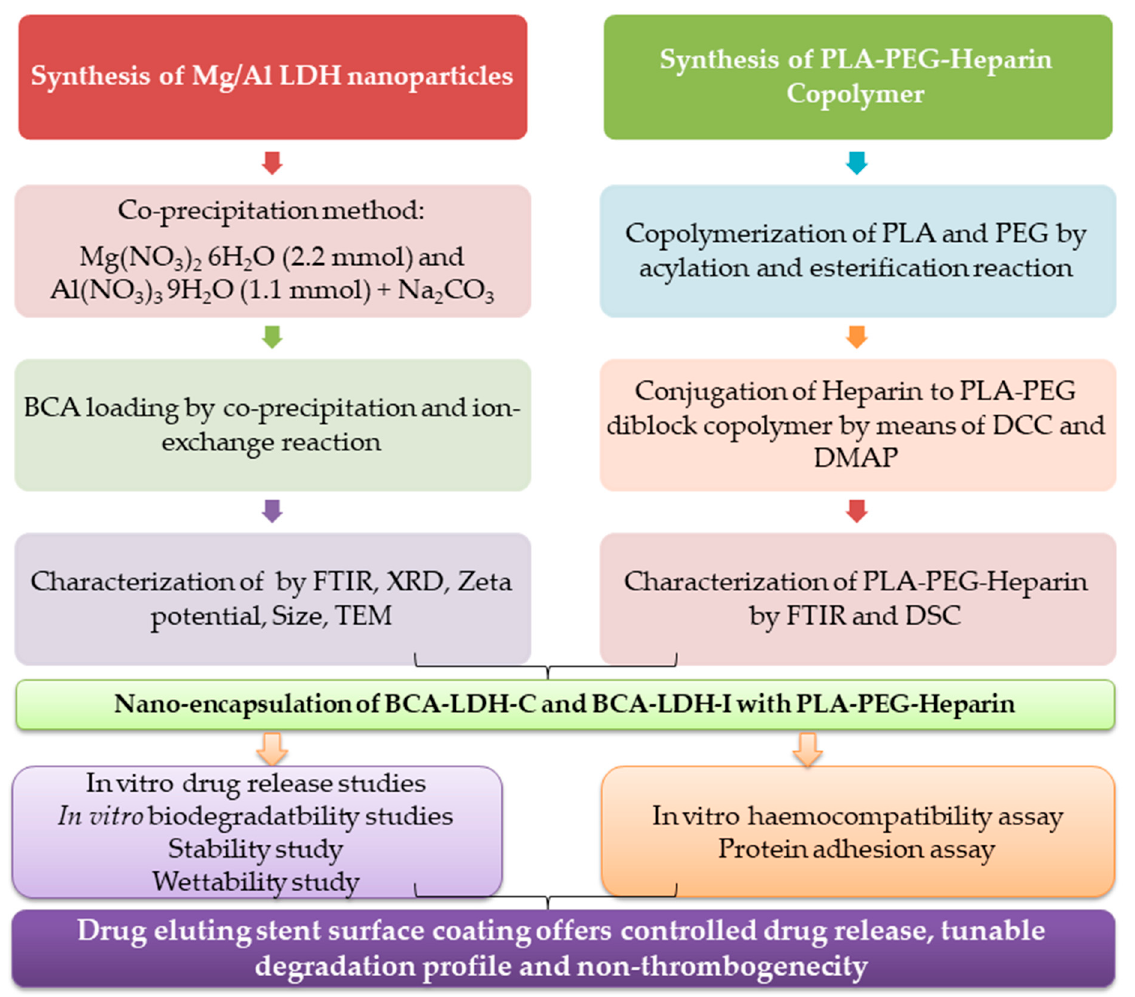
Figure 20. Schematic of the work flow.